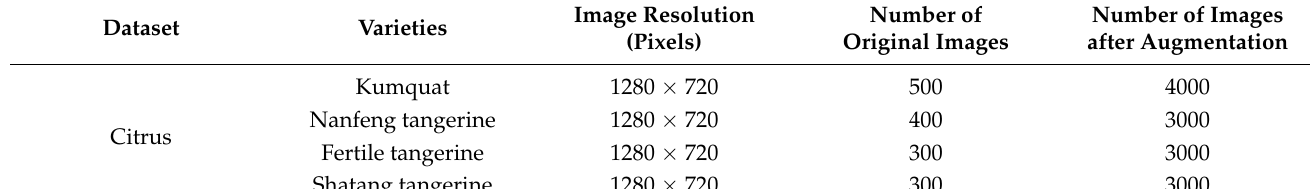
Table 1. The details of the citrus dataset.